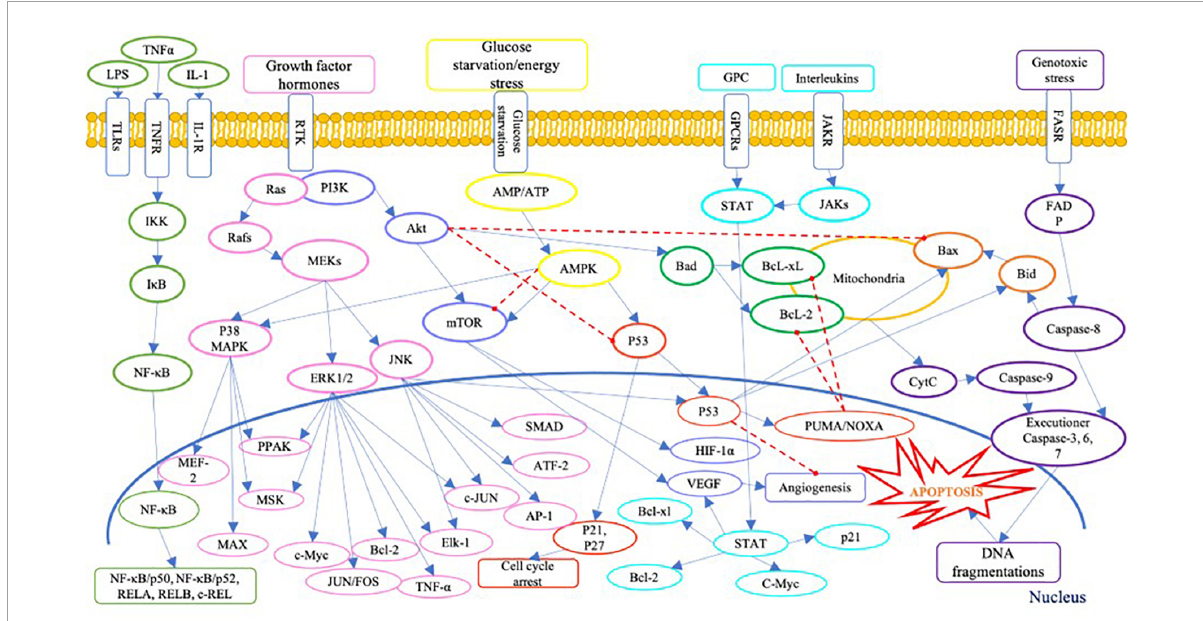
FIGURE3 A schematic of apoptosis signaling pathways. LPS, lipopolysaccharide; TNF α , tumour necrosis factor alpha; IL-1, interleukin-1; TLRs, Toll-like receptors; TNFR, tumor necrosis factor receptors; IL-1R, interleukin-1 receptor; GPC, G protein complex; GPCRs, G protein-coupled receptor; JAKR, Janus kinase receptor; FASR, Fas receptor; IKK, I κ B kinase; I κ B, inhibitor of NF- κ B; NF- κ B, nuclear factor (NF)- κ B; REL, REL protein; Ras, Ras protein; Rafs, Raf kinases; MAPK, mitogen-activated protein kinase; MEKs, MAPK/ERK kinase; ERK, extracellular signal-regulated kinase; JNK, c-Jun N-terminal kinases; MEF-2, myocyte enhancer factor-2; PPAK, family of p21-activated protein kinases; MSK, mitogen and stress activated protein kinase; MEK, mitogen-activated protein kinase; MAX, MAX protein; c-Myc, c-Myc protein; JUNFOS, Fos and Jun families of DNA binding proteins; Bcl-2, B-cell lymphoma 2; ELK-1, ETS transcription factor ELK1; AP-1, activator protein 1; ATF-2, activating transcription factor 2; PI3K, phosphoinositide 3-kinases; Akt, serine/threonine-protein kinases; mTOR, mammalian target of rapamycin; HIF-1 α , hypoxia inducible factor 1 subunit alpha; VEGF, vascular endothelial growth factor; AMP, adenosine monophosphate activated protein; ATP, adenosine triphosphate; AMPK, AMP-activated protein kinase; p53, protein p53; PUMA, p53 upregulated modulator of apoptosis; NOXA, (PMAP1) – phorbol-12-myristate-13-acetate-induced protein 1; Bcl-xl, B-cell lymphoma-extra large; Bad, Bcl-2 associated death promoter; Bax, Bcl-2 associated protein x; Bid, BH3 interacting domain death agonist; STAT, signal transducer and activator of transcription; JAKs, Janus kinases; FADP, flavin adenine dinucleotide; cytc, cytochrome complex